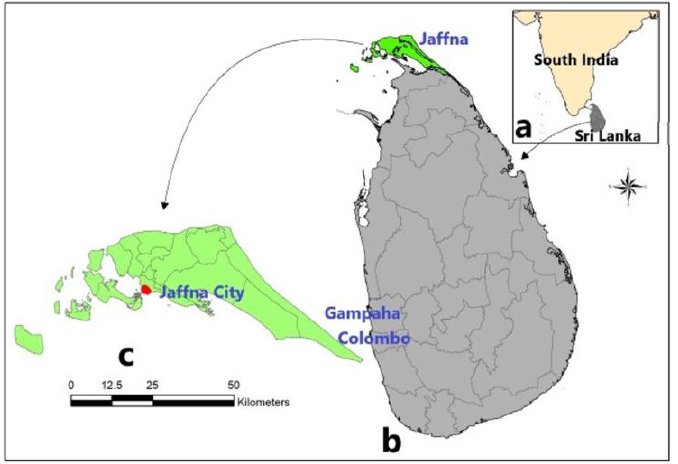
Figure 1. Map showing ( a ) the location of Sri Lanka in relation to India; ( b ) the boundaries of the 25 districts including Colombo, Gampaha, and Jaffna districts that have high dengue incidence; and ( c ) the location of the city of Jaffna within the Jaffna district. Table 1. Timeline of population movement restrictions with the aim of suppressing